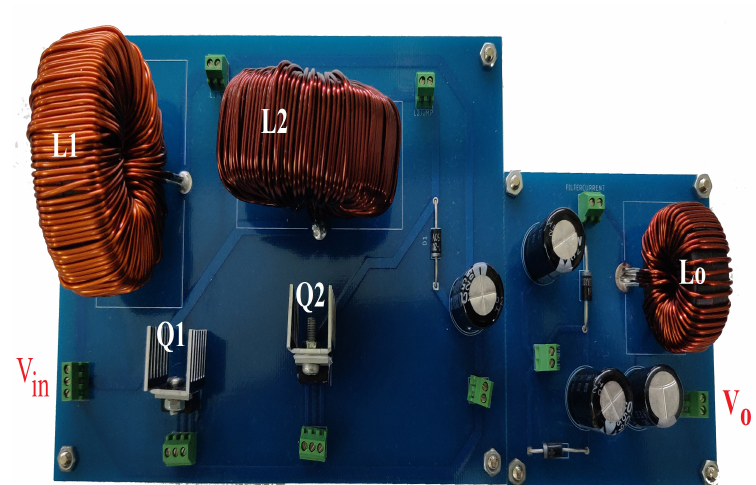
Figure 6. Prototype of the proposed converter.